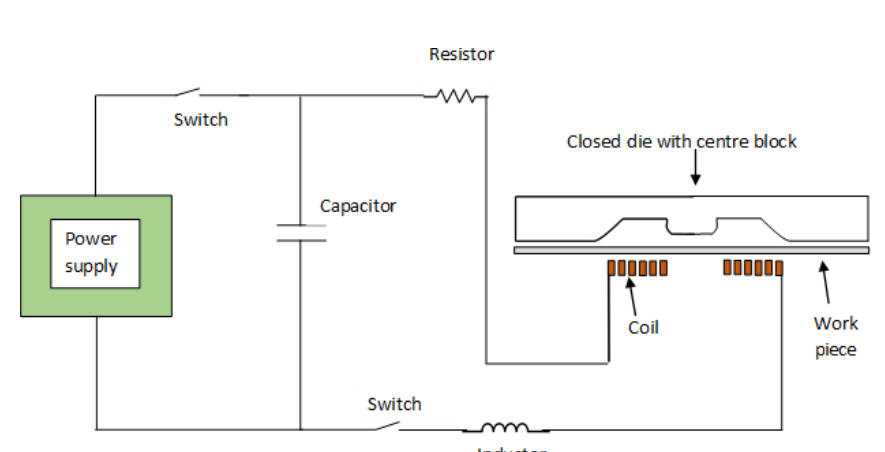
Figure 5. Schematic of the electromagnetic forming system.